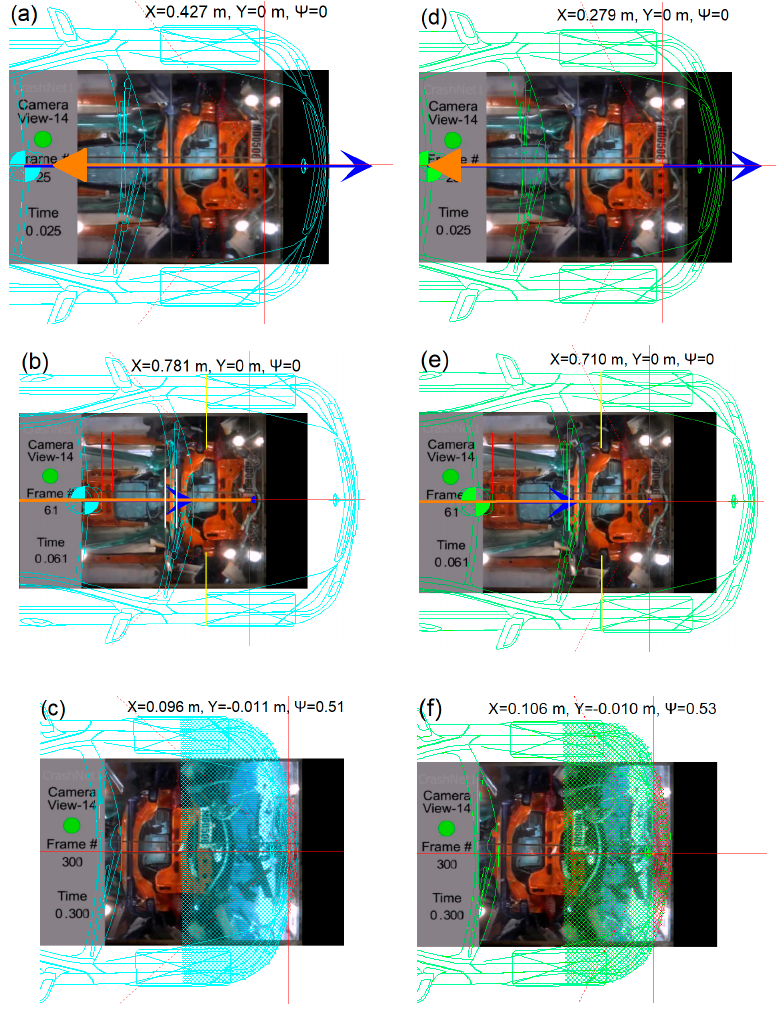
Figure 9. Comparison of the vehicle undercarriage projections with recorded images for default data: t = 25 ms ( a ), t = 61 ms ( b ), t = 300 ms ( c ), identified data: t = 25 ms ( d ), t = 61 ms ( e ), and t = 300 ms ( f ).